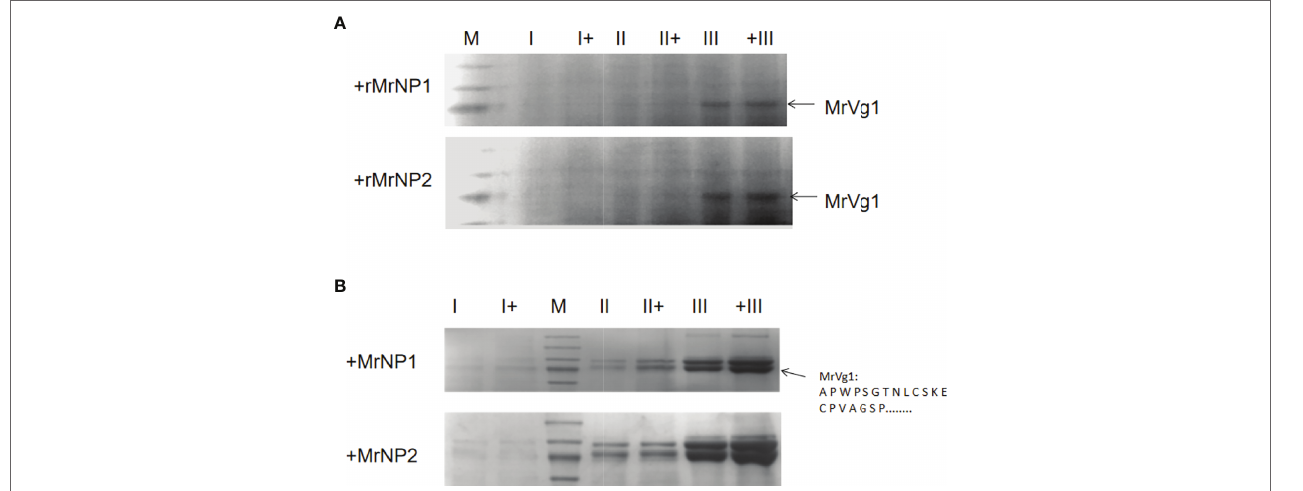
FIGURE 8 | Analysis of hepatopancreas (A) and ovary (B) tissue protein by 7% SDS-PAGE after in vitro treatment with recombinant protein for MrNP1 and MrNP2 (N = 3). Representative Coomassie Blue-stained gel after SDS-PAGE. Each lane represents protein extracted from the from medium. Protein in gel (78 kDa, arrow) was excised, and the amino acid sequence was determined by amino acid sequencing and confirmed to be MrVg as previously (Okuno et al., 2002). Hepatopancreas from the early (stage I), middle (stage II), and late (stage III) stages of ovary maturation were either incubated with (+) or without the recombinant proteins (i.e., rMrNP1 and